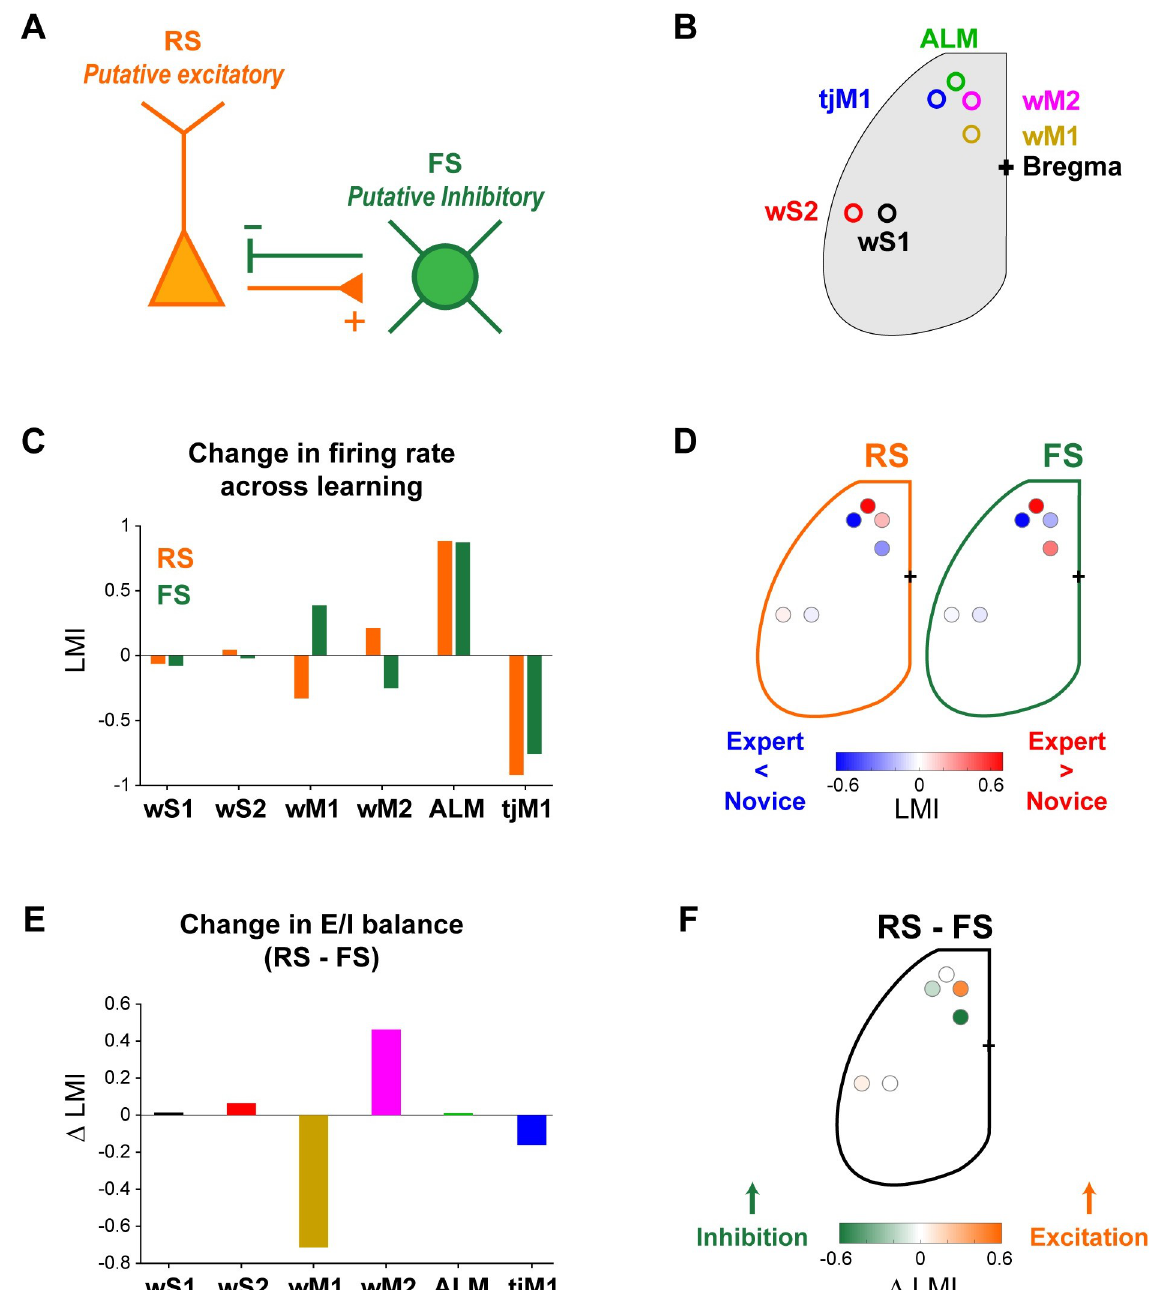
Fig 8. Diverse changes of putative excitation–inhibition balance in different cortical regions across learning. (A) FS (putative PV GABAergic inhibitory) neurons and RS (putative glutamatergic excitatory pyramidal) neurons are typically considered to be strongly and reciprocally connected in local cortical microcircuits providing fast balance of excitation and inhibition. (B) Schematic showing the location of different cortical regions. (C) LMI in different cortical regions for RS and FS units, representing learning-induced change in putative excitation and inhibition, respectively. LMI was quantified as the normalized difference between whisker-evoked firing rate in Novice and Expert mice. (D) Map of the putative excitation–inhibition change across learning, shown as LMI across cortical regions for RS and FS neurons. (E) Change in the putative excitation–inhibition balance across learning, quantified as difference between LMI of RS and FS neurons in different cortical regions. (F) Cortical map of the putative excitation–inhibition balance change across learning, calculated as LMI difference between RS and FS neurons. The underlying data for Fig 8 can be found in S10 Data. ALM, anterior lateral motor cortex; FS, fast spiking; LMI, learning modulation index; PV, parvalbumin-expressing; RS, regular spiking; tjM1, tongue-jaw primary motor cortex; wM1, whisker primary motor cortex; wM2, whisker secondary motor cortex; wS1, whisker primary somatosensory cortex; wS2, whisker secondary somatosensory cortex.